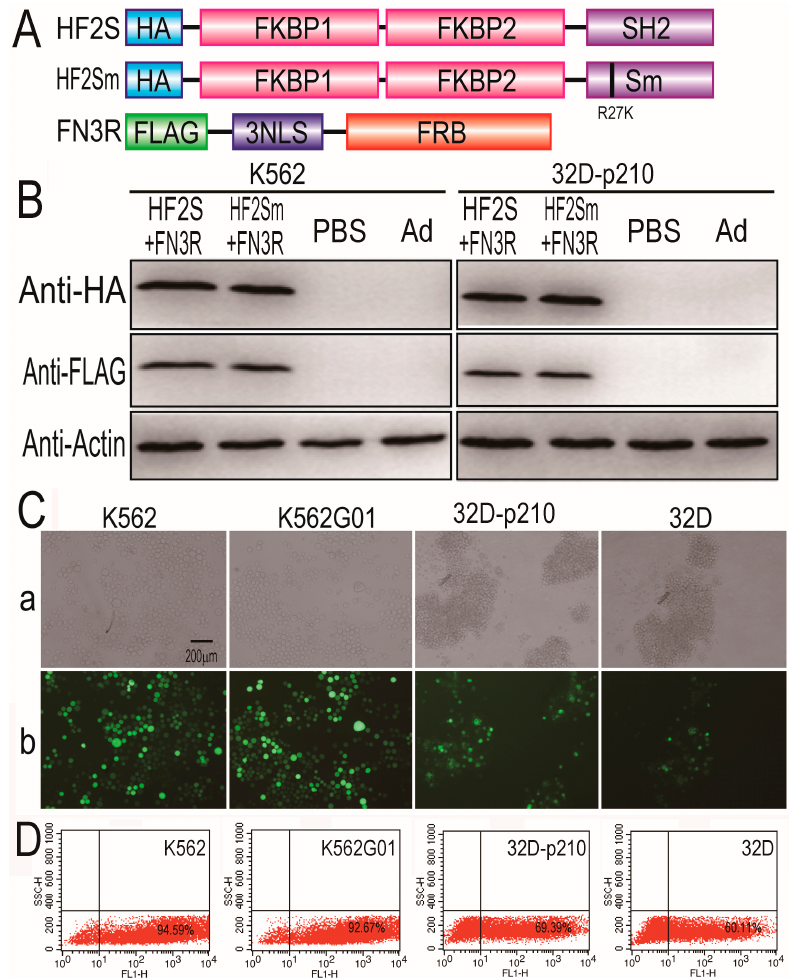
Figure 1. Expression of HF2S, HF2Sm and FN3R by adenoviral vectors: ( A ) the structure of Ad5/F35-HF2S, Ad5/F35-HF2Sm and Ad5/F35-FN3R vectors; ( B ) Western blot was applied for assessing the expression of the exogenous HF2S, HF2Sm and FN3R in adenovirus-infected K562 and 32D-p210 cells, compared with phosphate-buffered saline (PBS) and Ad5/F35-CMV (empty vector) (Ad); ( C ) adenoviral Green fluorescent protein (GFP) expression in K562, K562G01, 32D-p210 and 32D cells as observed under the inverted fluorescent microscope. The cells were infected with the Ad5/F35-GFP control adenovirus for 48 h, and the virus infection efficiency were observed under the inverted fluorescent microscope ( b ) and the image under light microscope ( a ) were also included (scale bars = 200 µ m); and ( D ) flow cytometry was applied to confirm the infected efficiency of Ad5/F35-GFP.